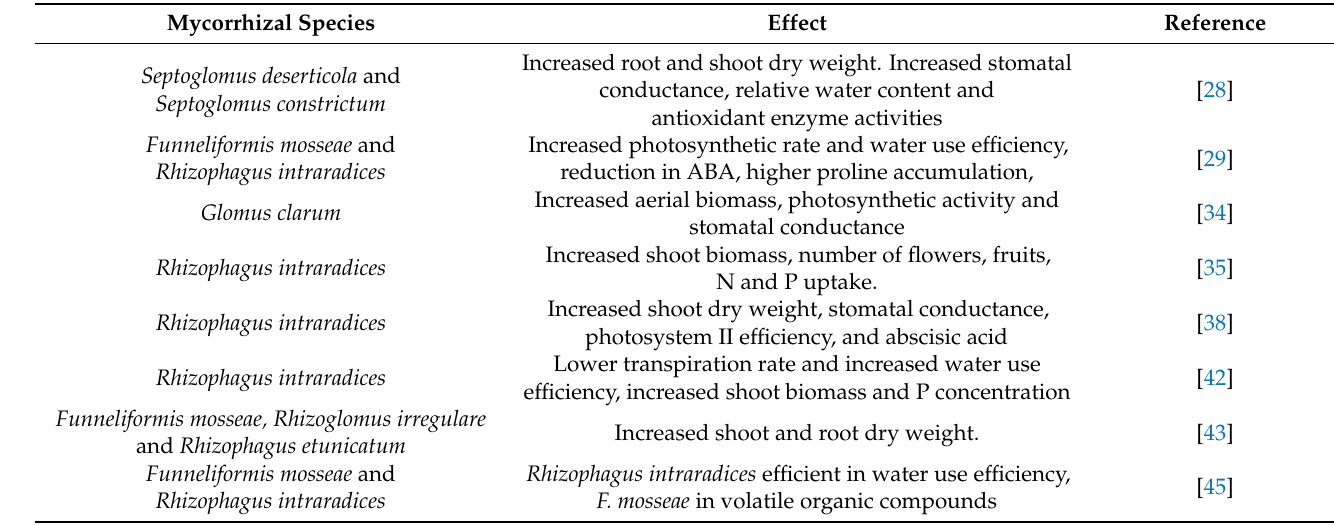
Table 1. Application of arbuscular mycorrhizal fungi on drought stress